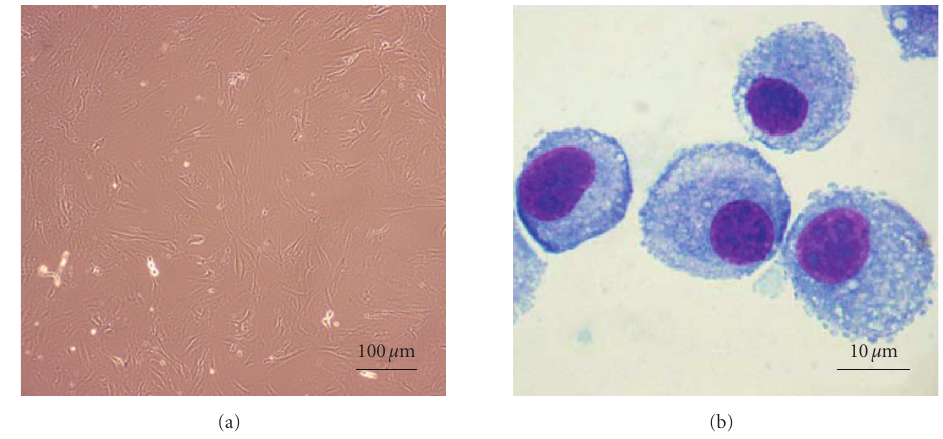
Figure 2: Mesenchymal stem cell morphology by light microscopy. (a) MSCs culture ( × 100), (b) Cytospin and Giemsa stained ( ×